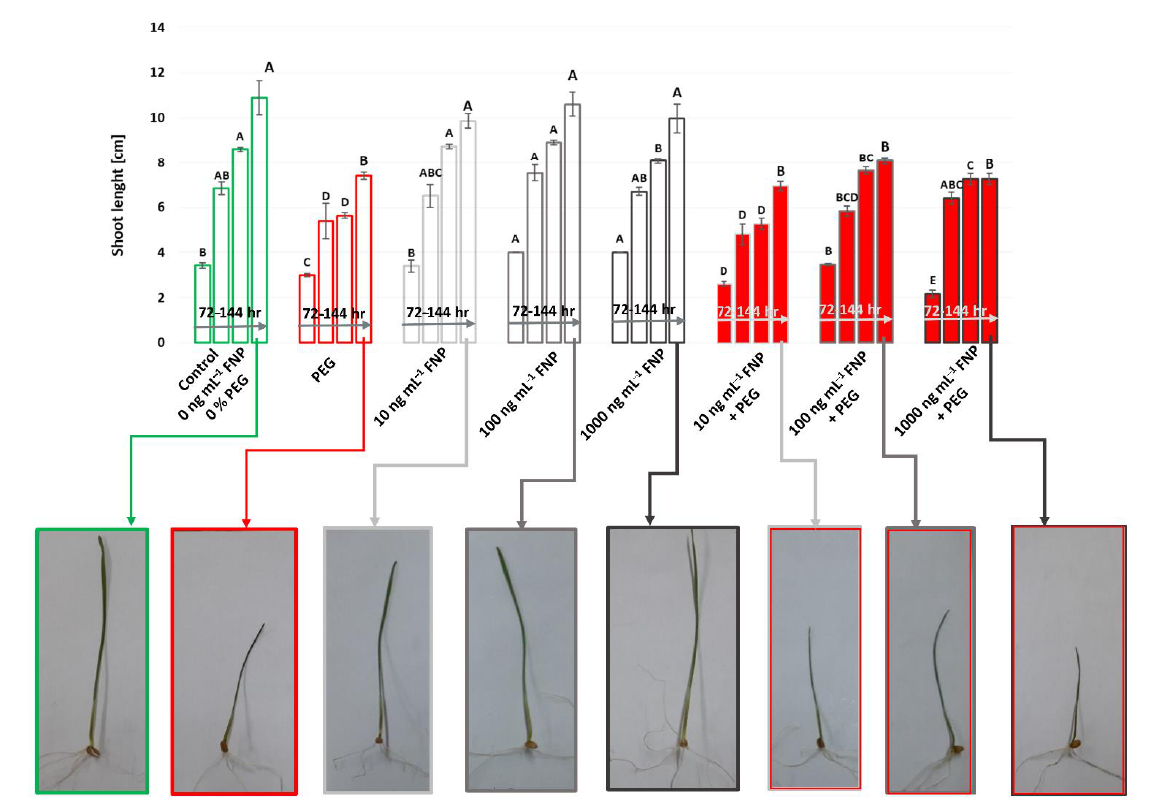
Figure 3. Shoot length under drought (PEG), fullerol C 60 (OH) 24 nanoparticles (FNP; 0, 10, 100 and 1000 ng mL − 1 ) and combined FNP–PEG treatments (10 ng mL − 1 FNP+ PEG, 100 ng mL − 1 FNP + PEG, and 1000 ng mL − 1 FNP + PEG) during 72, 96, 120 and 144 h (from left–right). Shoot length is measured from period of 72 to 144 hr. Photos represent average shoot length for all treatment after 144 hr. Values are means ± S.D. ( n = 3). The different letters indicate statistically significant differences among the mean values of different treatments at p < 0.05 using Tukey’s post-hoc test.